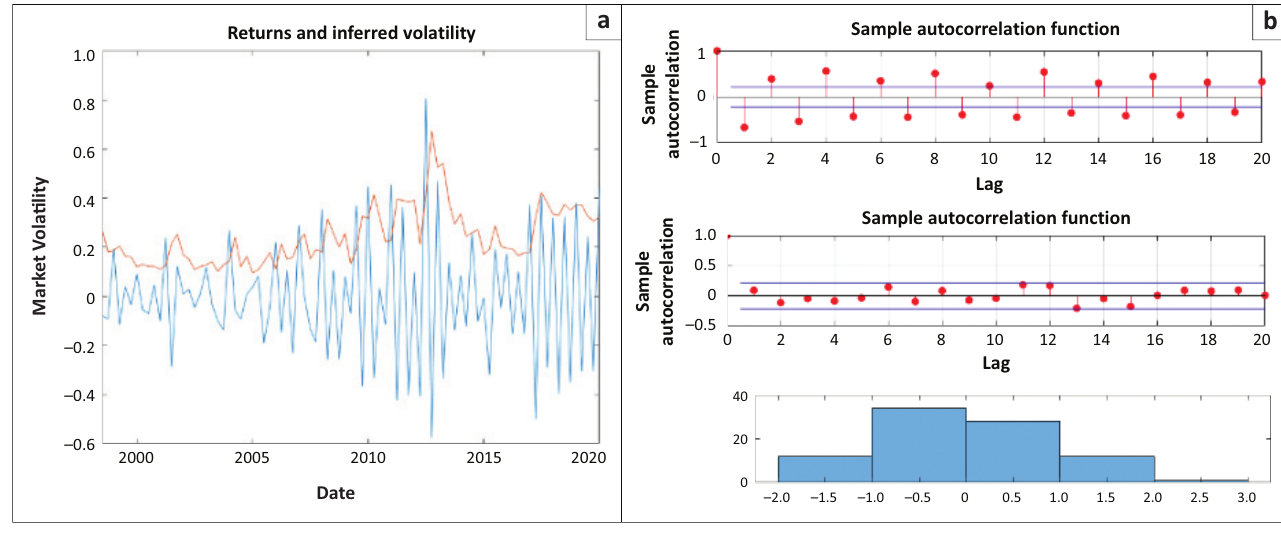
6. Modelling Global Art Price Index USD autoregressive integrated moving average quarterly data.